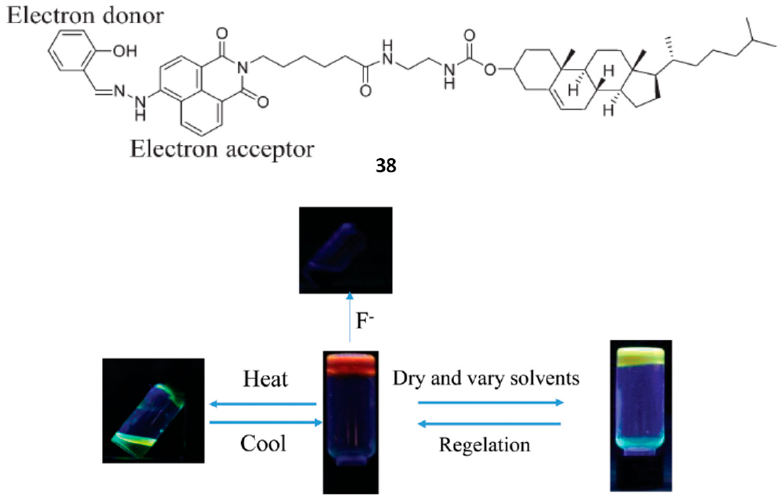
Figure 30. Chemical structure of organogelator 38 and photos of the fluorescent changes in its gels in the dark (irradiated at 365 nm) triggered by multiple stimuli. Adapted with permission from RSC [65].